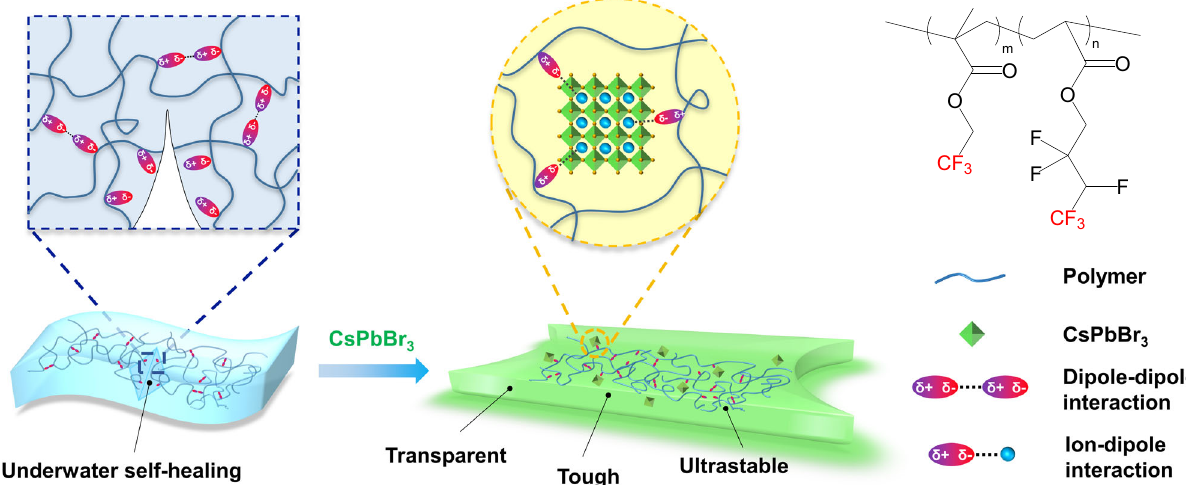
Fig. 1 The design of TFE-HF-QD. Schematic illustration of the stretchable, stable and self-healable luminescent perovskite-polymer